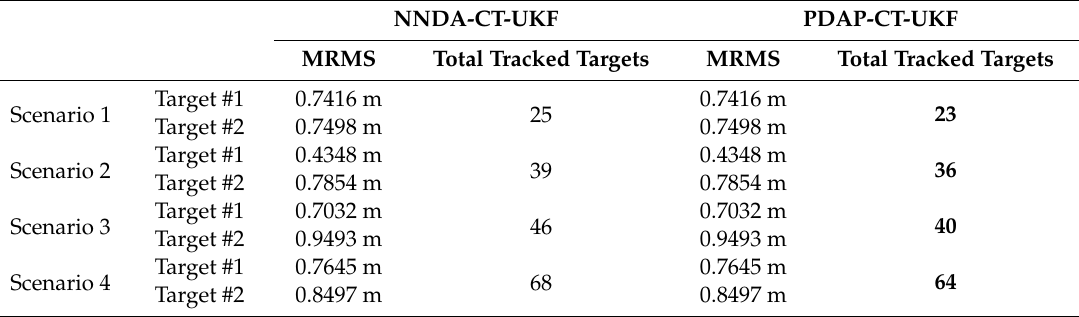
Table 1. Tracking